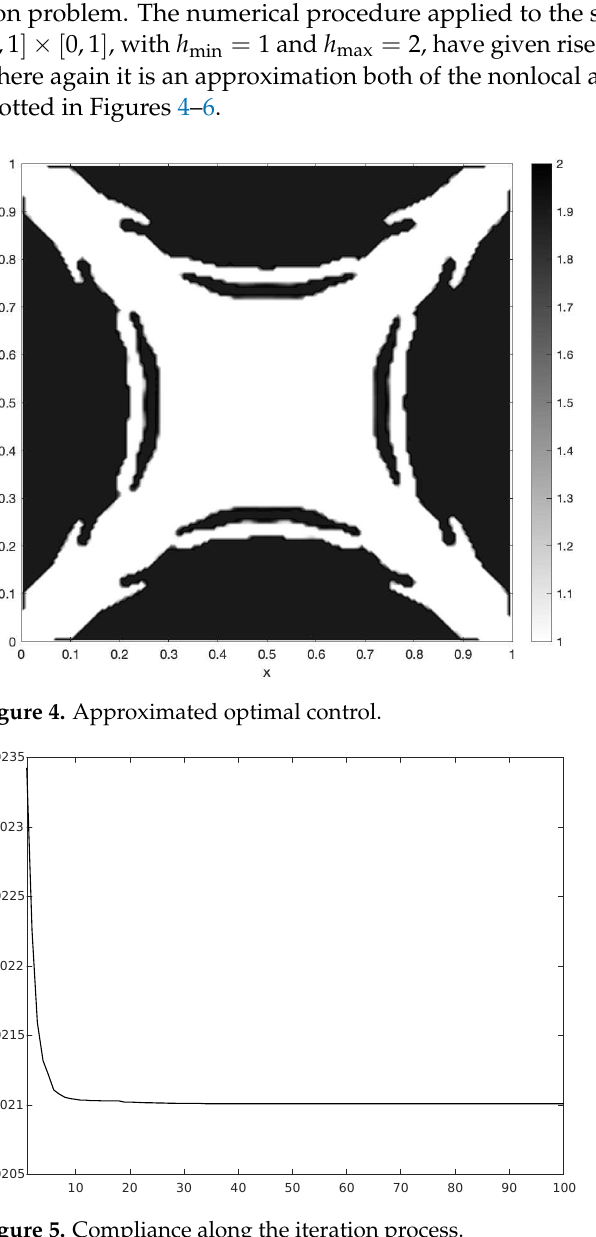
Figure 5. Compliance along the iteration process Figure 6: Approximation of the optimal estate Minimum Compliance 0 . 01